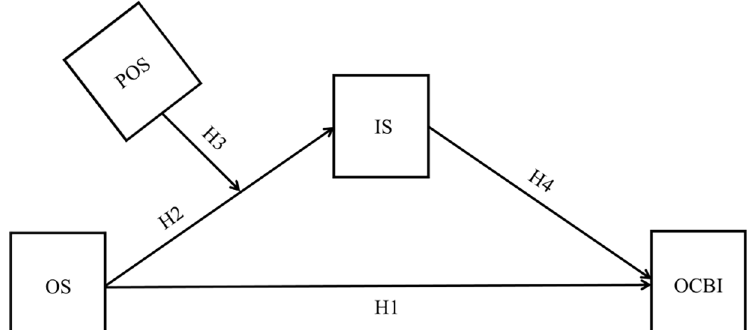
Fig 1. The hypothesized model. Legend: OS: Organizational socialization; POS: Positivity; IS: Interpersonal strain; OCBI; Organizational citizenship behaviors toward individuals.